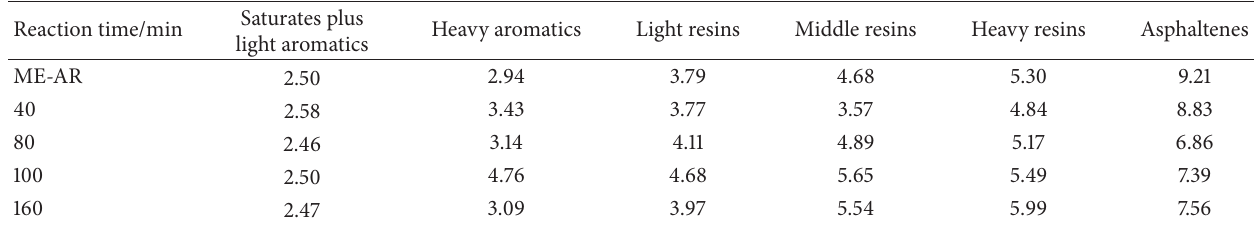
Table 2: Dielectric permittivity of samples of ME-AR thermal reaction at 400 ∘ C.